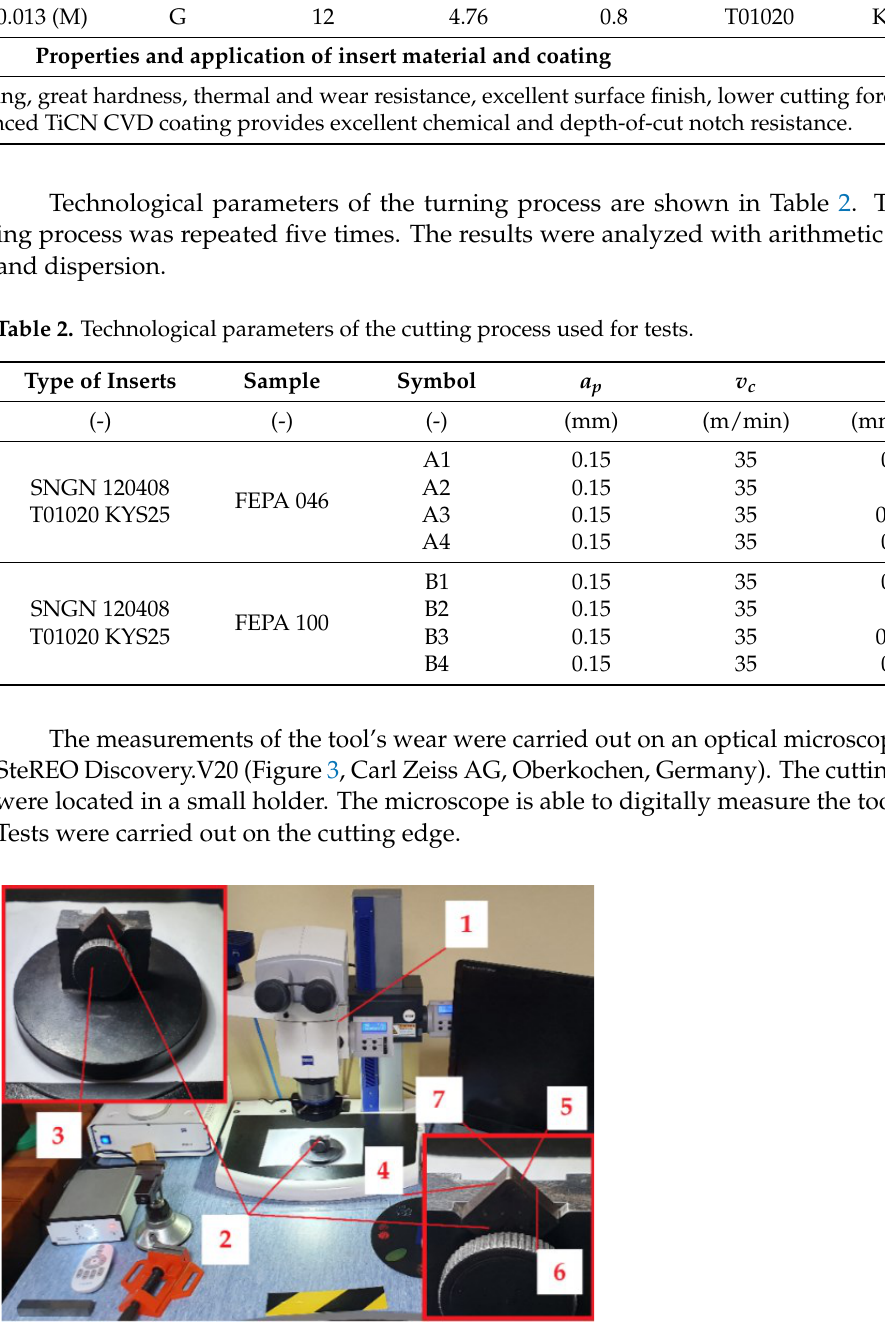
Figure 3. The tool ’ s wear measurements on a laboratory station with ZEISS SteREO